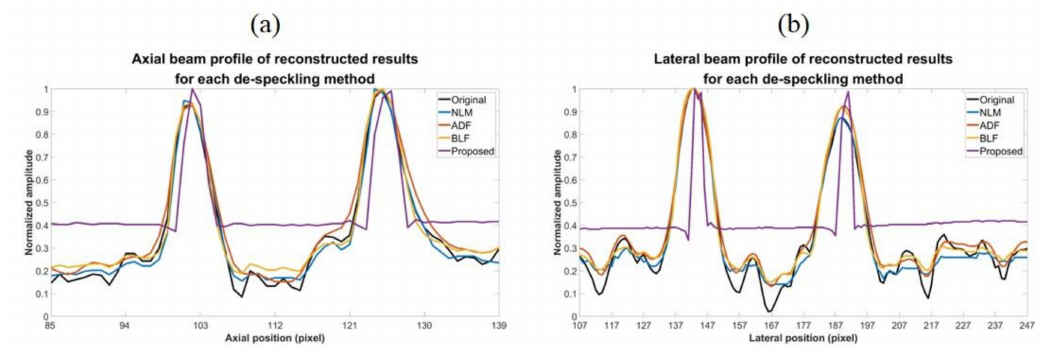
Figure 10. ( a ) Axial and ( b ) lateral profiles of the wire targets respectively in the red box and the yellow box of the reconstructed images for each de-speckling